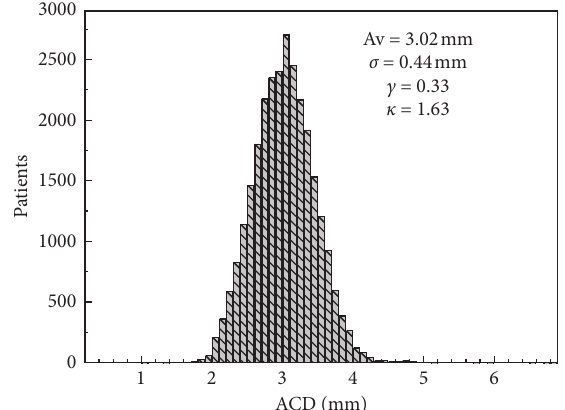
Figure 2: Histogram of the anterior chamber depth with bins of 0.2mm. In the inset, the main statigraphs of the distribution are shown.